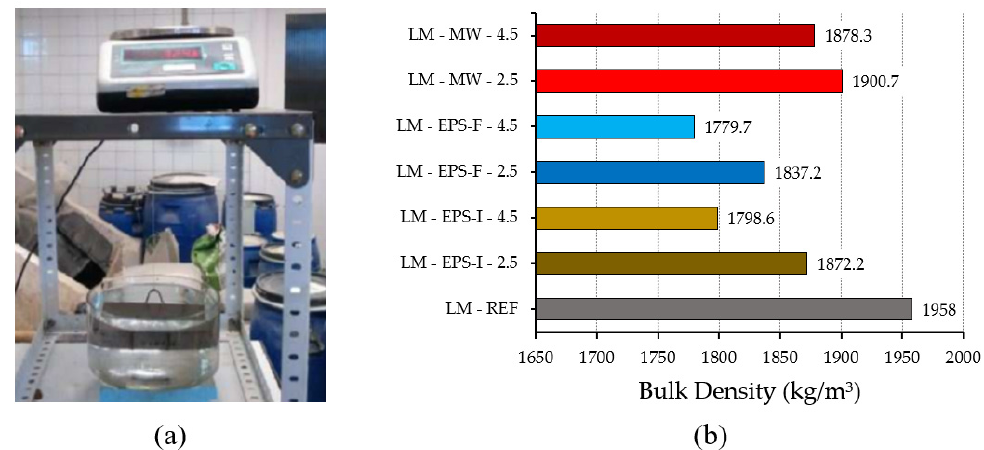
Figure 7. Apparent density. ( a ) Hydrostatic balance and taking measurements; ( b ) results obtained for the different mortars. Table 11. Statistical analysis for the density test (kg/m 3 ) for each group of mortar and its comparison.